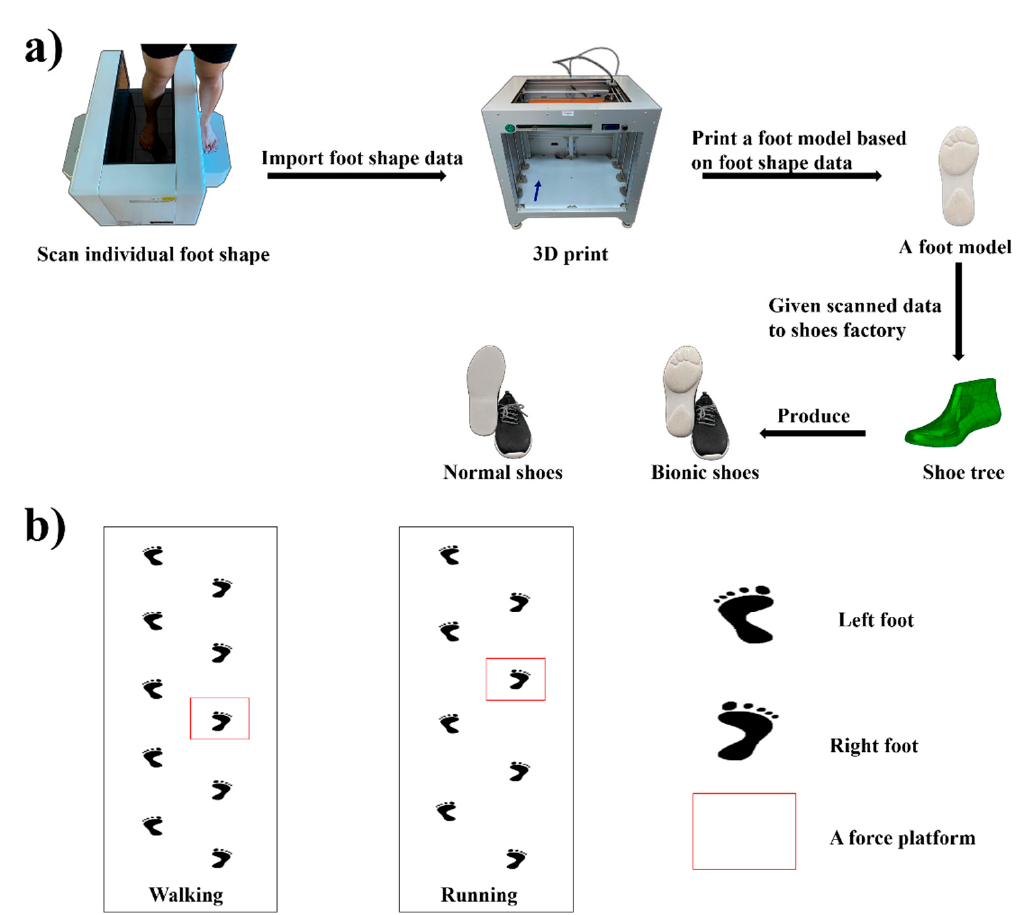
Figure 1. ( a ) Illustration of shoe-making procedures. ( b ) Illustration of experiment design for collecting the kinematics and dynamics data during the walking and running between the NS and the BS.